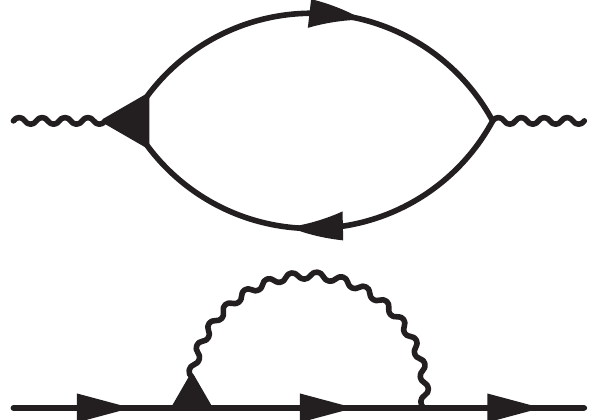
FIG. 2. Diagrammatic expressions for Π ð q Þ (top diagram) and Σ ð k Þ (bottom diagram). Solid lines are fully dressed fermion propagators G ð k Þ , wavy lines are fully dressed boson propagators D ð q Þ , and solid triangles are fully dressed vertex